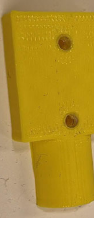
Fig. 8. Finger modification for the use case.